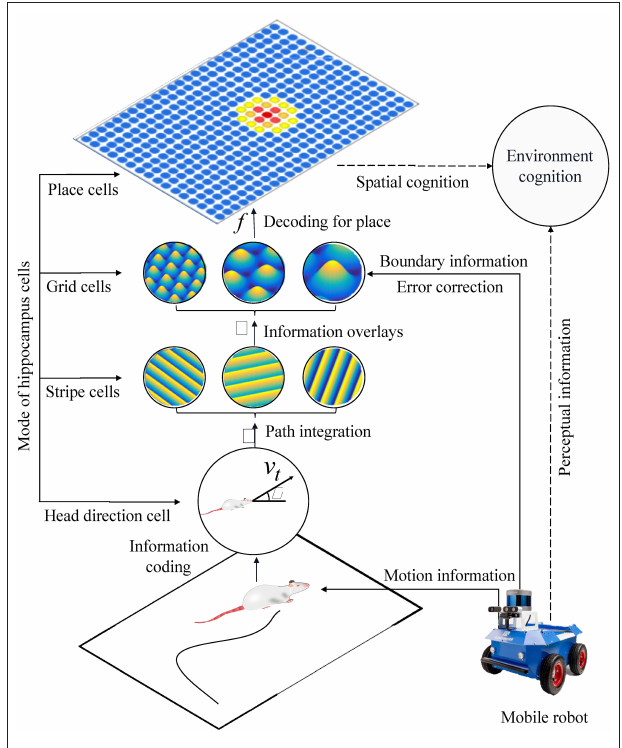
FIGURE 8 | The figure shows the system architecture of the bionic spatial cognitive model on the mobile robot. The process of robot spatial cognition includes the following steps: (1) Head direction cells and stripe cells code the robot’s motion information and integrate the paths. (2) The neural information from stripe cells to grid cells is integrated into two-dimensional space. (3) The boundary information corrects the grid cells integration error according to the memory of synaptic weight. (4) By decoding the firing signals of multi-scale grid cells, our model realized the one-to-one expression of physical